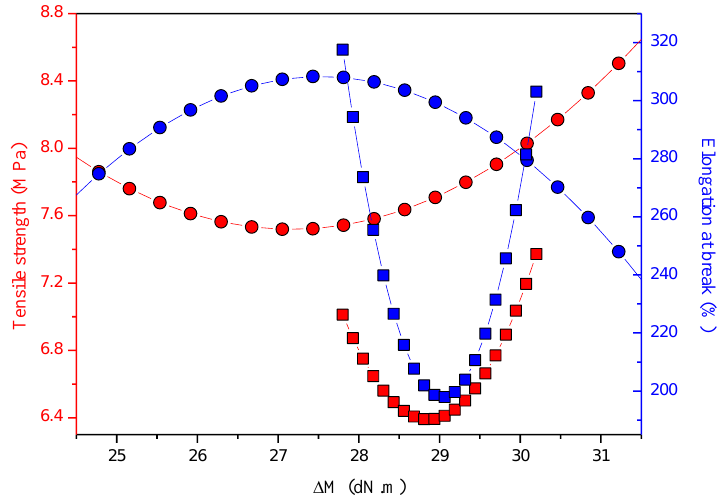
Figure 4. Influence of the ∆ M on the tensile strength and elongation at break behavior of the blends. The circles are the EPDM-r samples and the squares are the EPDM-r UV samples.